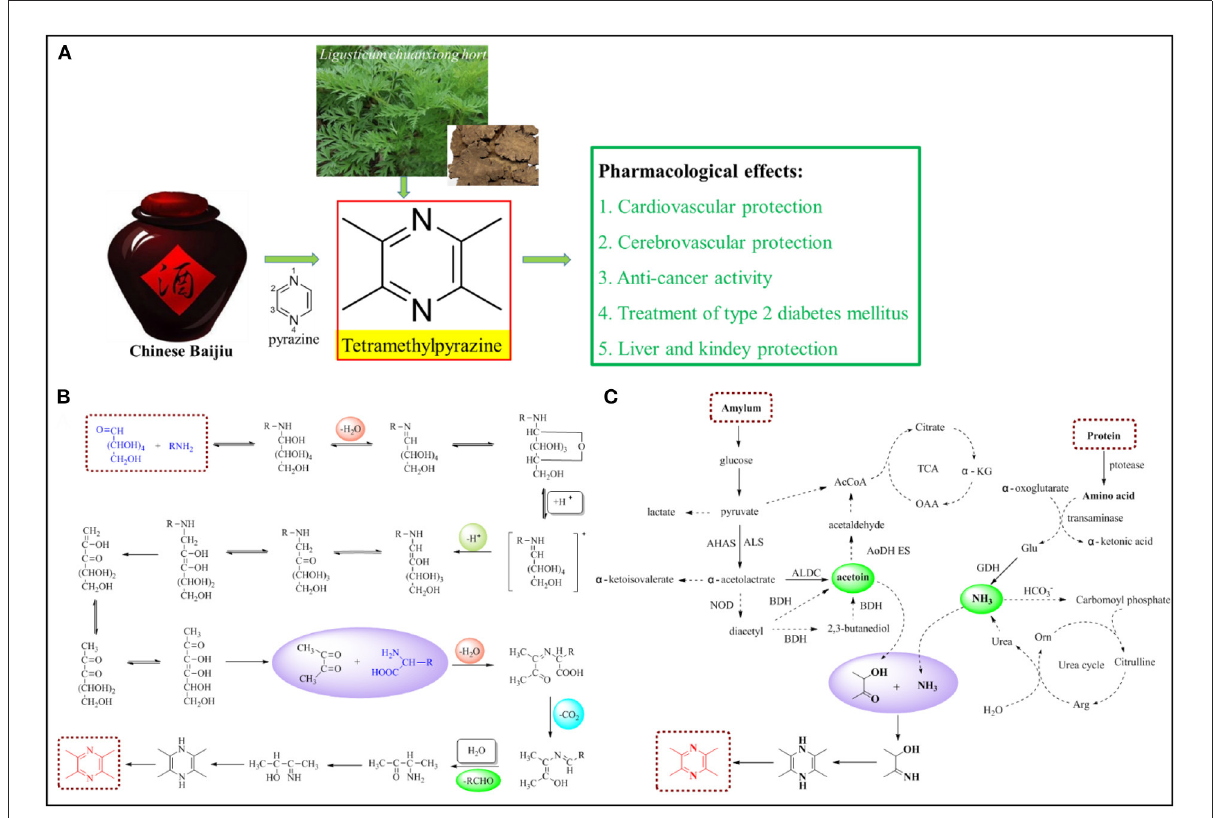
FIGURE1 Structure and functions of TMP (A) ; the Maillard reaction (B) and microbial synthesis (C) to produce